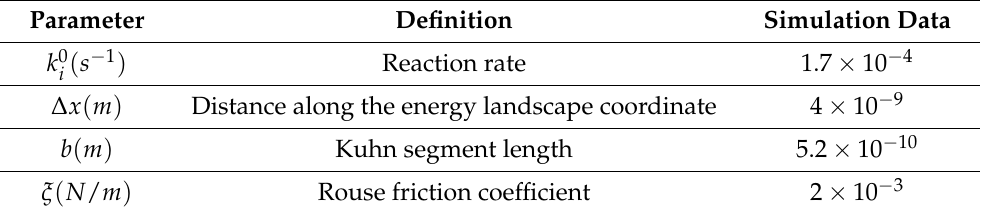
Table 1. Model parameters used in this